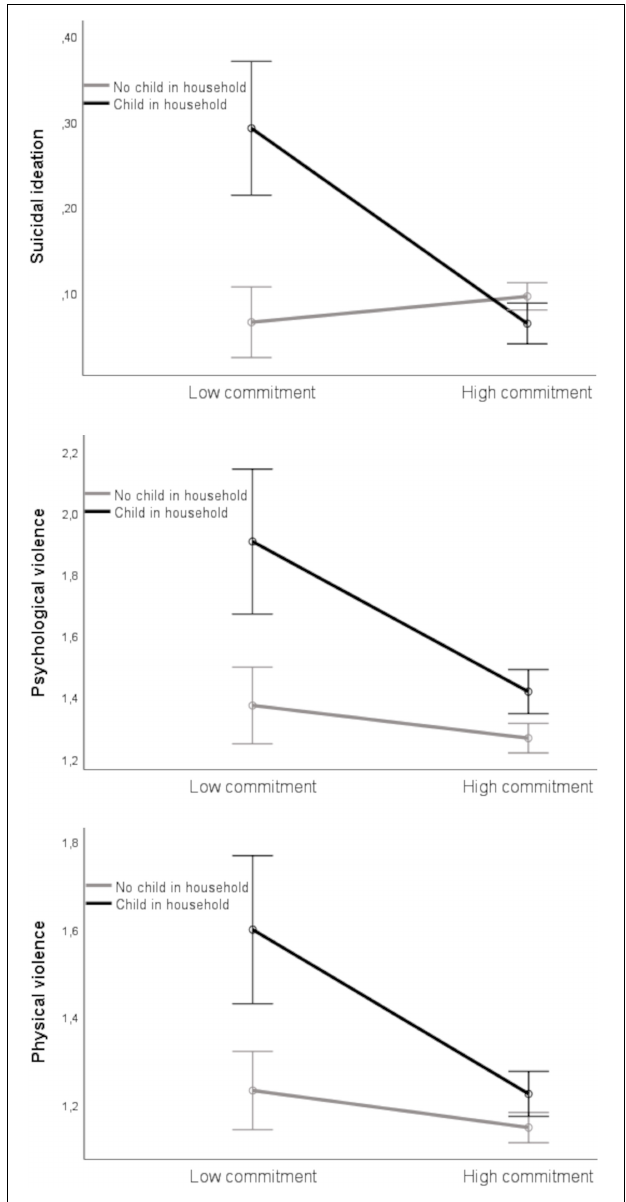
FIGURE 1 | Suicidal ideation, psychological violence, and physical violence by relationship commitment and family